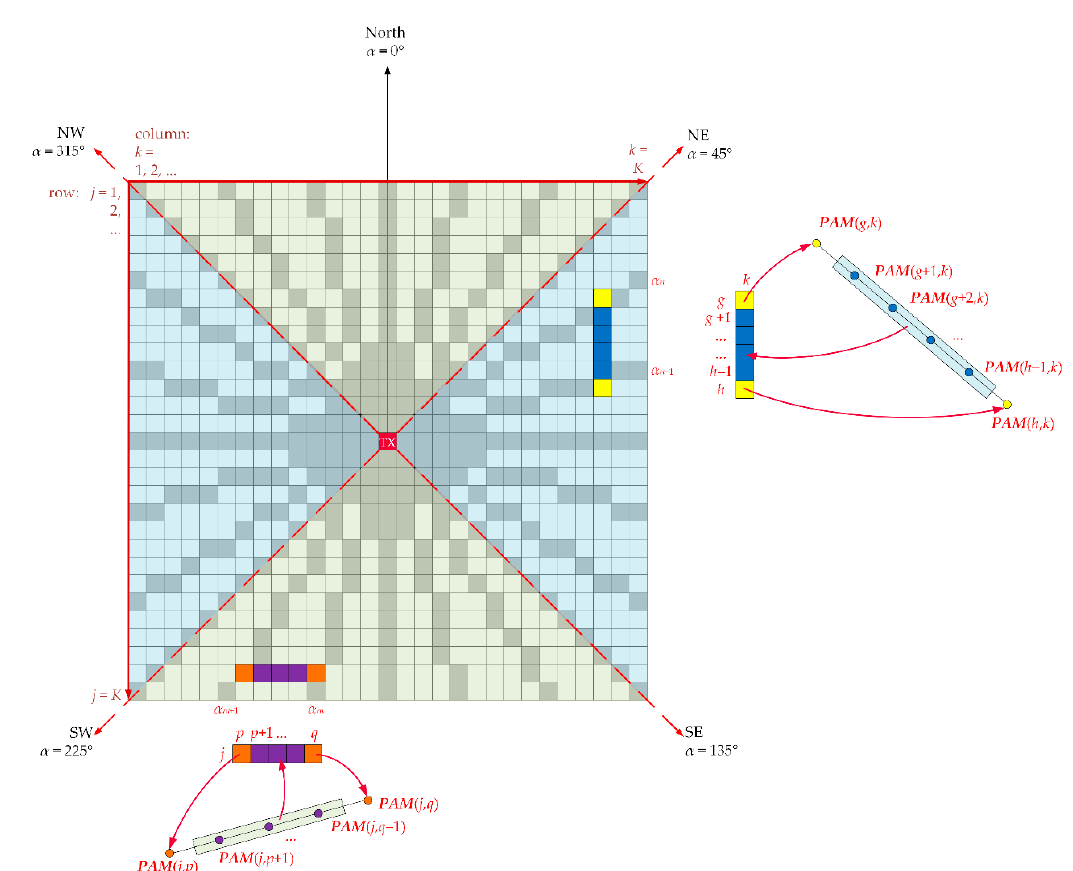
Figure 2. Interpolation method for creating full PAM matrix.